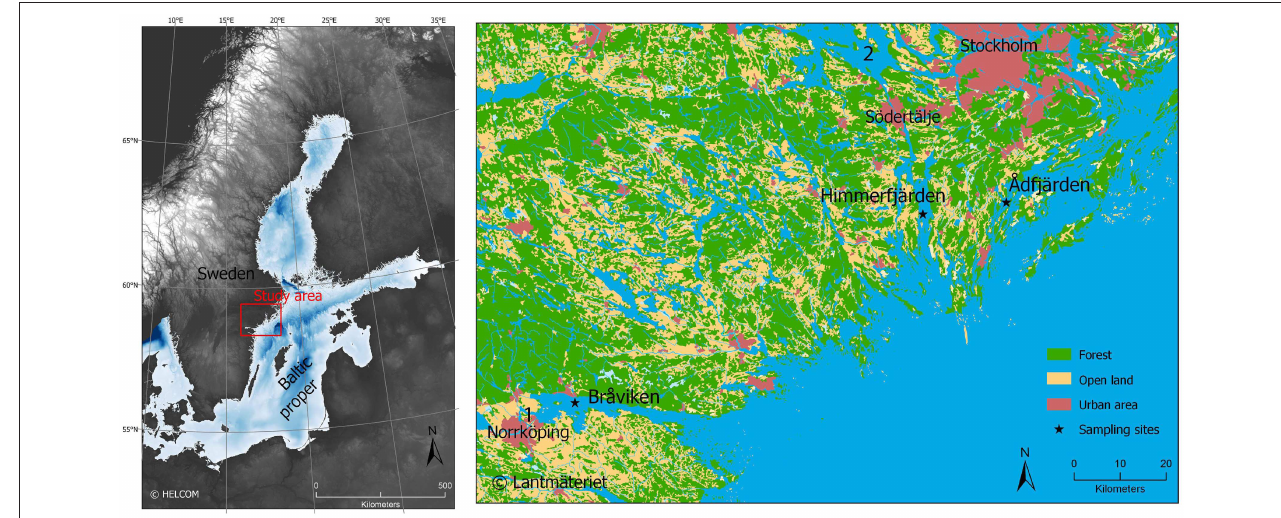
FIGURE 1 | Maps showing the location of the three investigated sites Bråviken, Himmerfjärden, and Ådfjärden in the Baltic Sea. Number 1 is Motala ström and number 2 is Lake Mälaren.